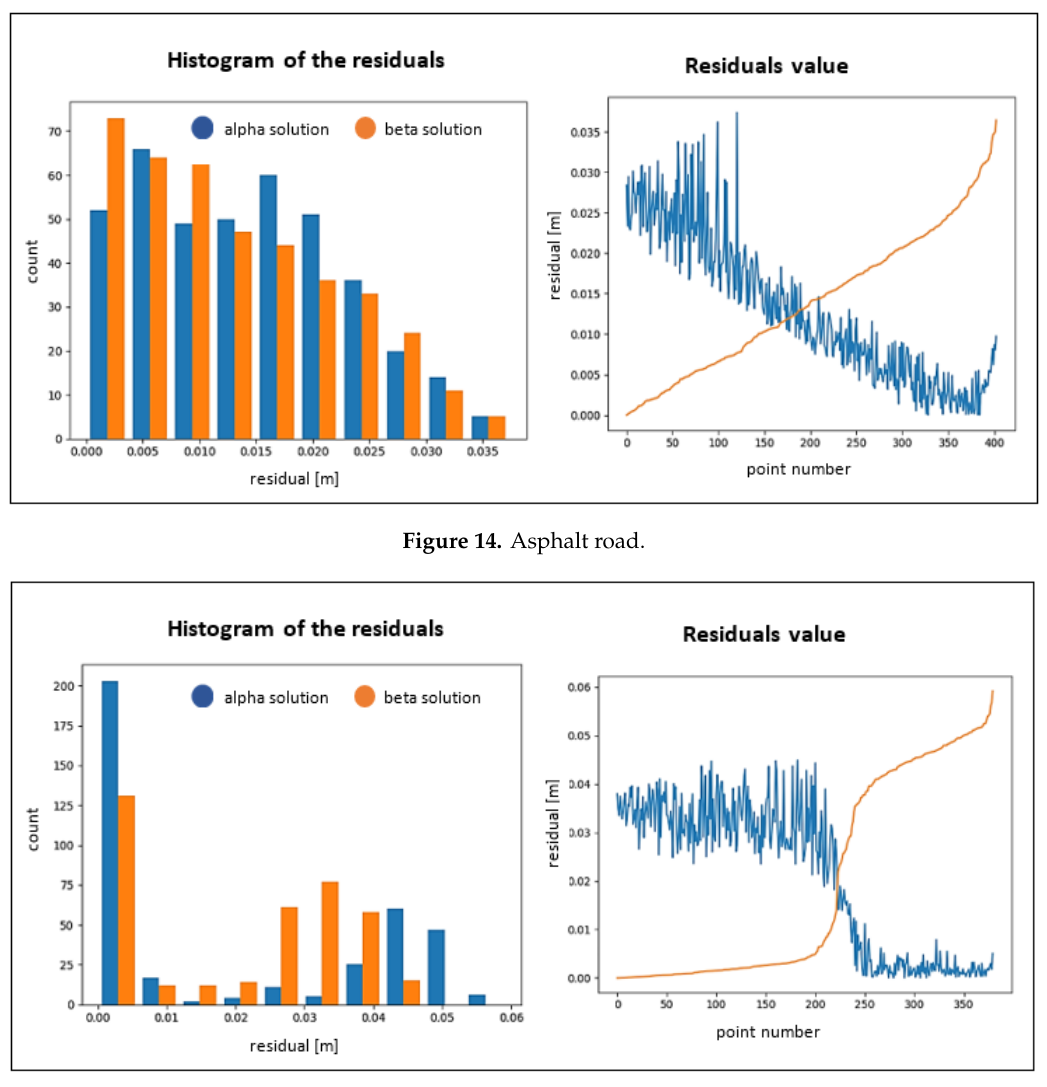
Figure 15. Concrete pavement.